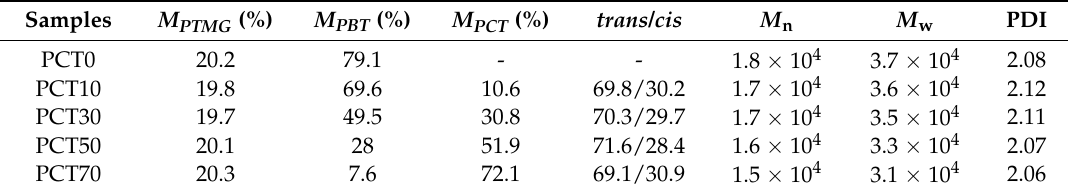
Table 2. Compositions, molecular weights and polydispersity of the (PBT-co-PCT)-b-PTMG copolymers.